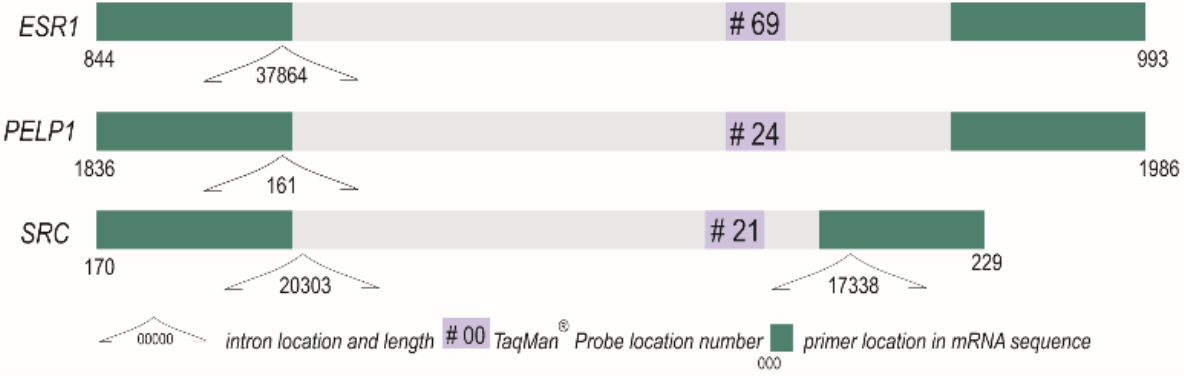
Figure 8. Amplicons of the analyzed genes ESR1, PELP1 and SRC with their primers, TaqMan ® Probes and introns positions. ESR2 and HPRT (reference) probe assays are protected by trade secrets.